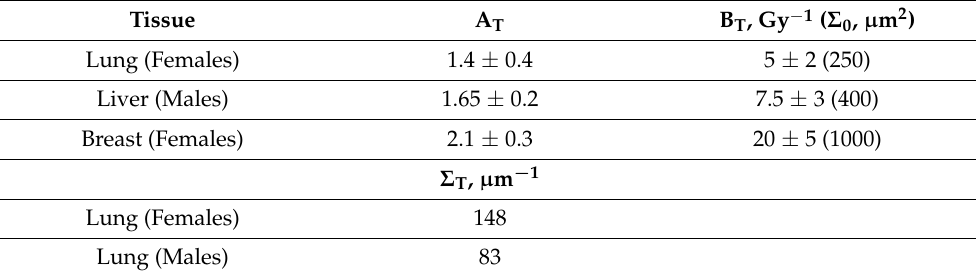
Table 4. DERR model preferred parameters for cancer risk in several tissues.